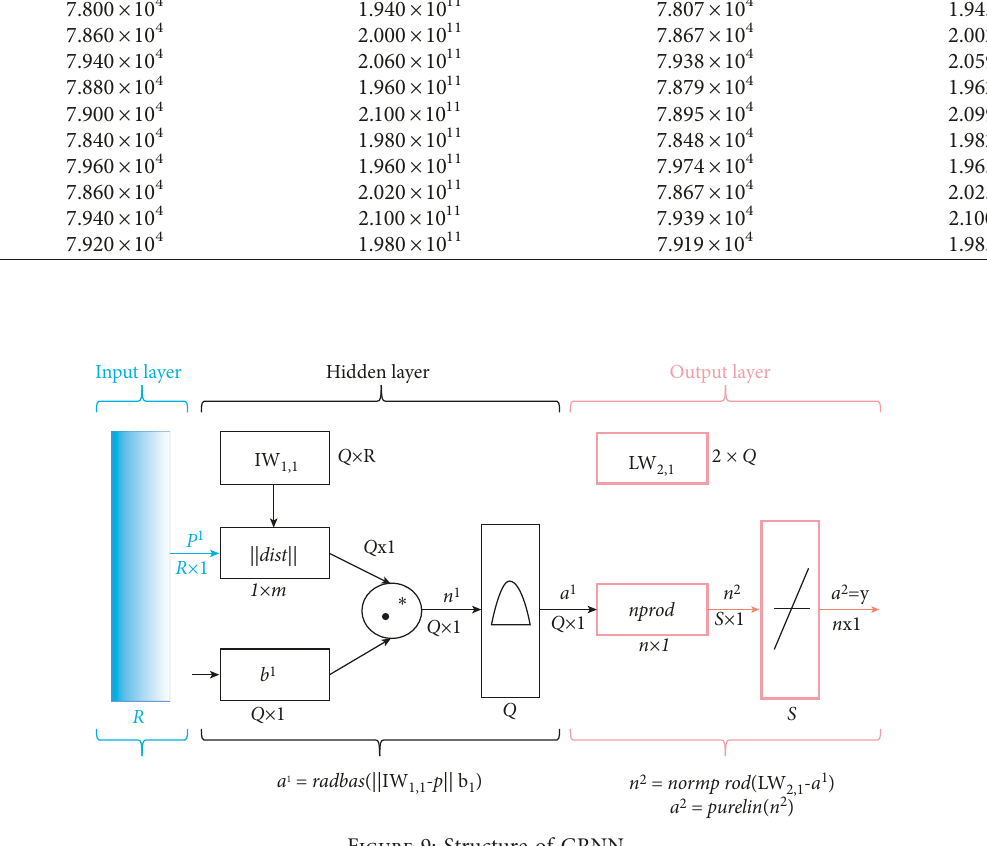
Figure 9: Structure of